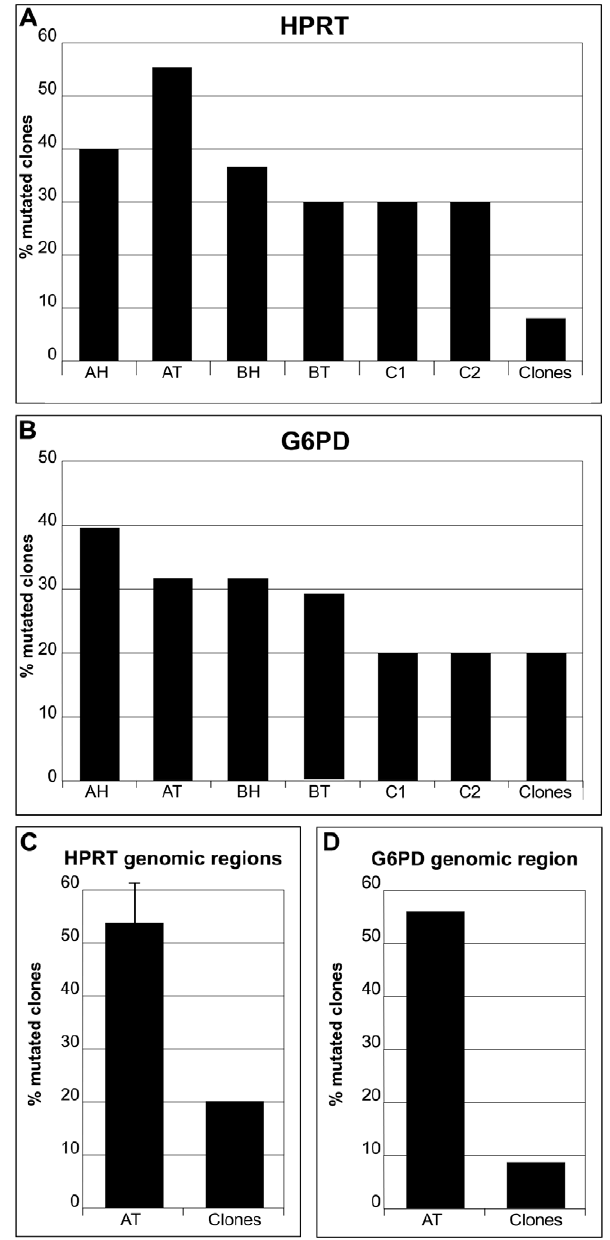
Figure 2. Percent mutated clones of HPRT and G6PD cDNA and genomic regions. Panel A, values of HPRT transcripts; Panel B, values of G6PD transcripts. Panel C, values of HPRT genomic regions; Panel D, values of G6PD genomic regions. Percent values have been calculated on pooled data from each independent analysis. AT and BT, values of clones of Tumour tissues of patients A and B, respectively; AH and BH, values of clones of Healthy tissues near tumours. C1 and C2, values of reference samples. Clones, values of control samples.